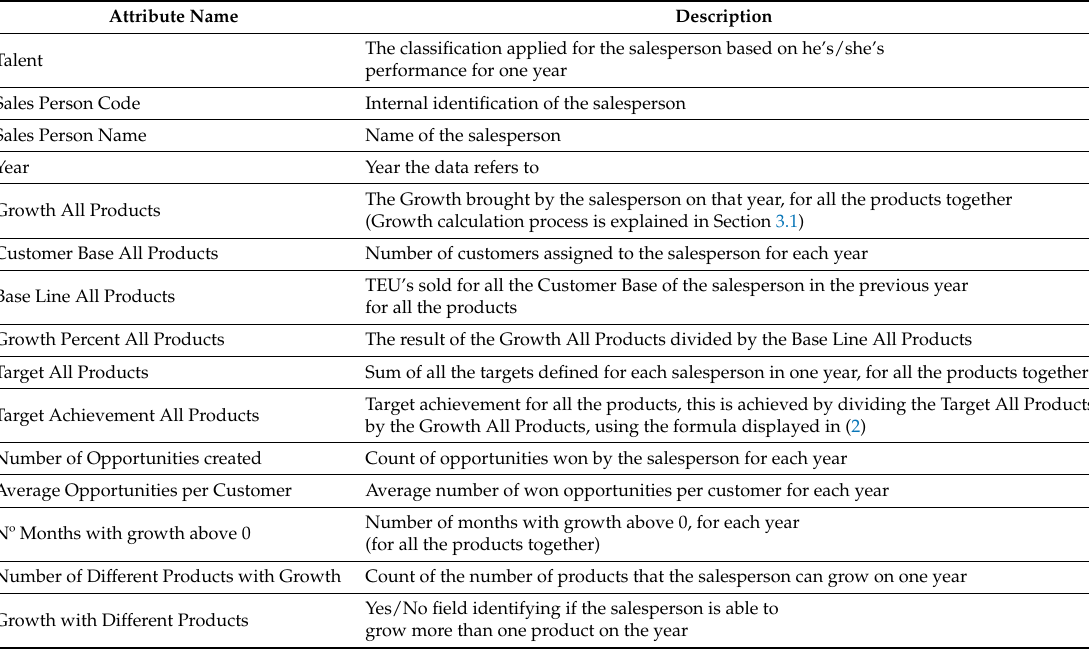
Table 1. Main attributes